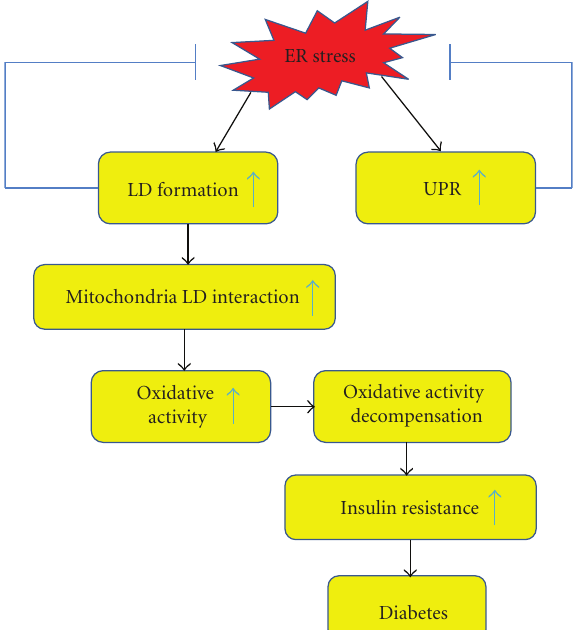
Figure 1: Interactions between ER stress, oxidative stress, and lipid droplets in type II diabetes. LD, lipid droplet; UPR, unfolded protein